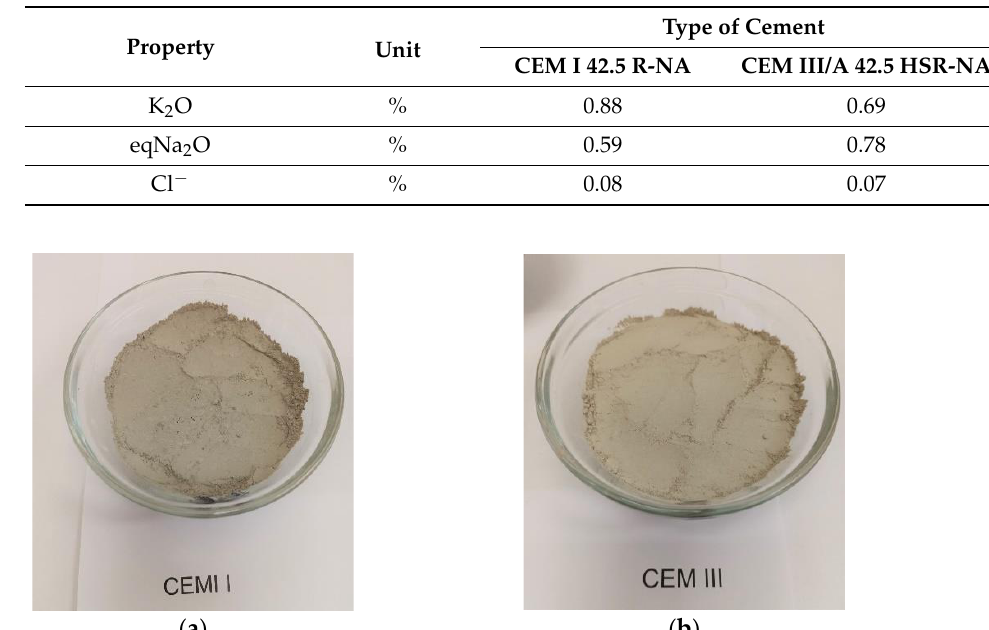
Figure 1. Pictures of cement samples: ( a ) CEM I 42.5 R-NA; ( b ) CEM III/A 42.5 HSR-NA.